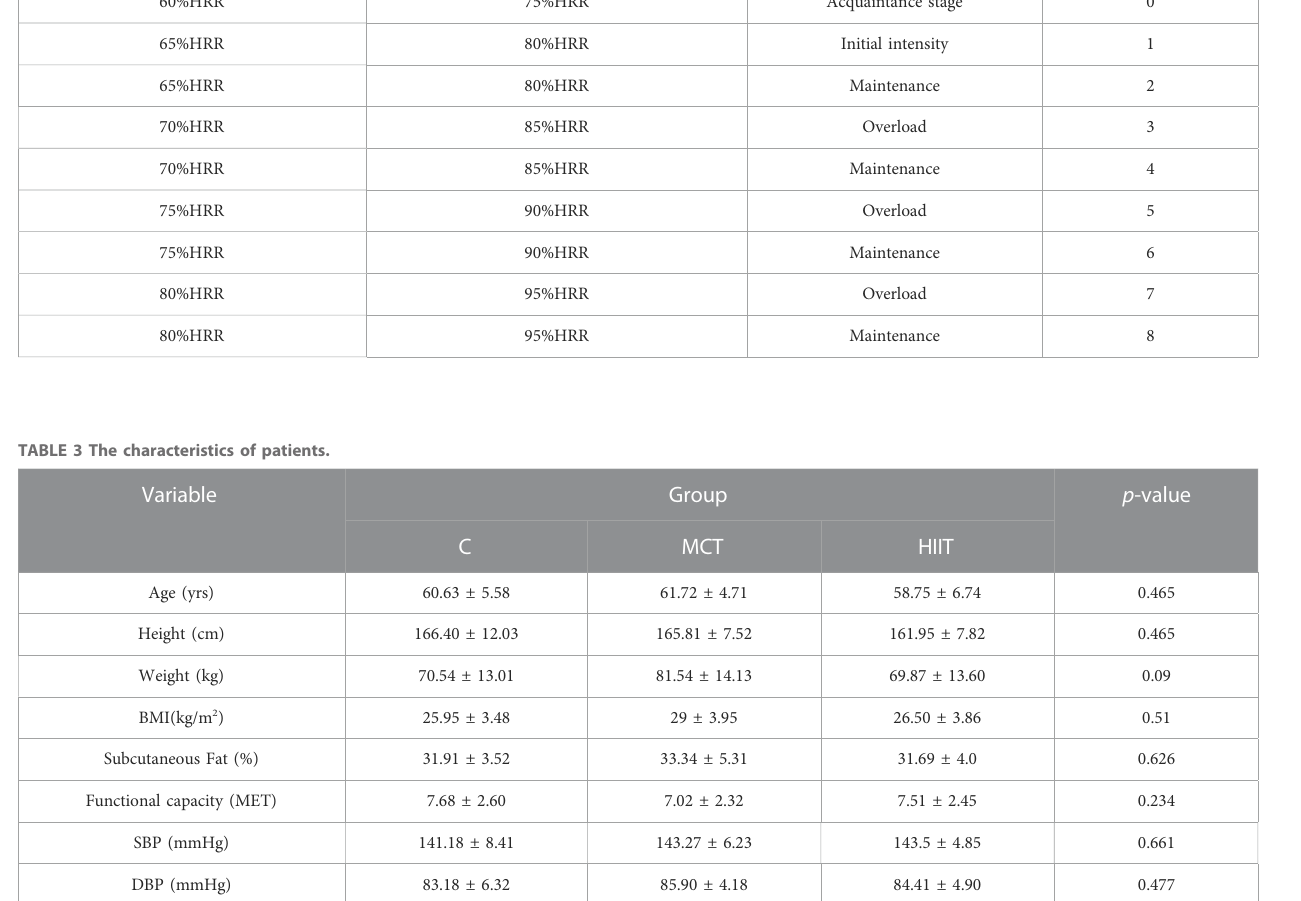
TABLE 2 The mode of intensity overload in the HIIT group. (HRR: heart rate reserve). Moderate intervals